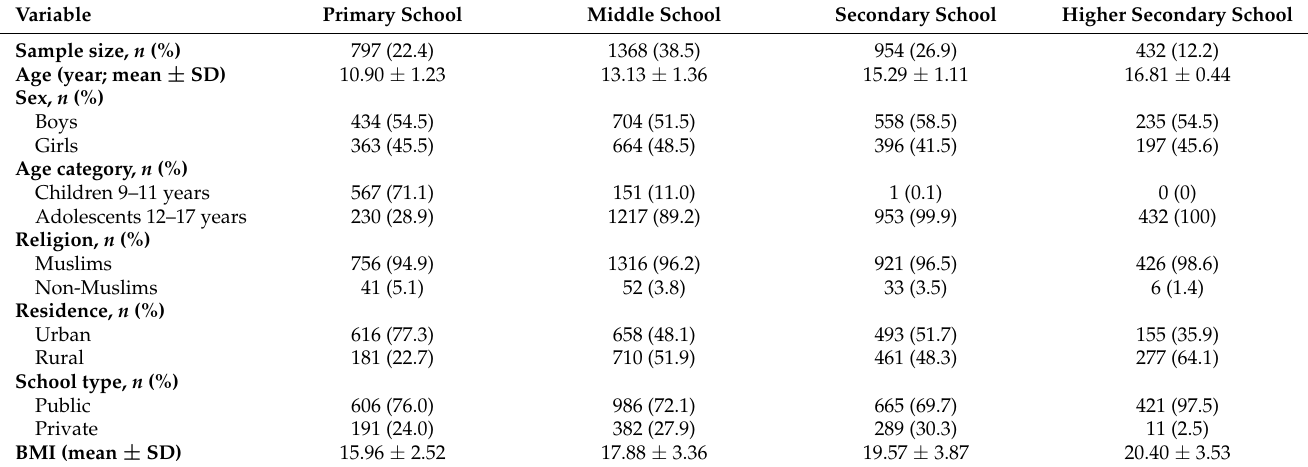
Table 1. Descriptive statistics of demographic characteristics.